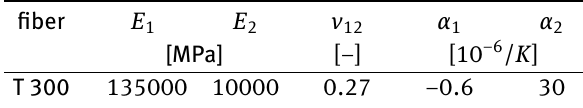
Table 1: Relevant material properties of unidirectional T300/epoxy